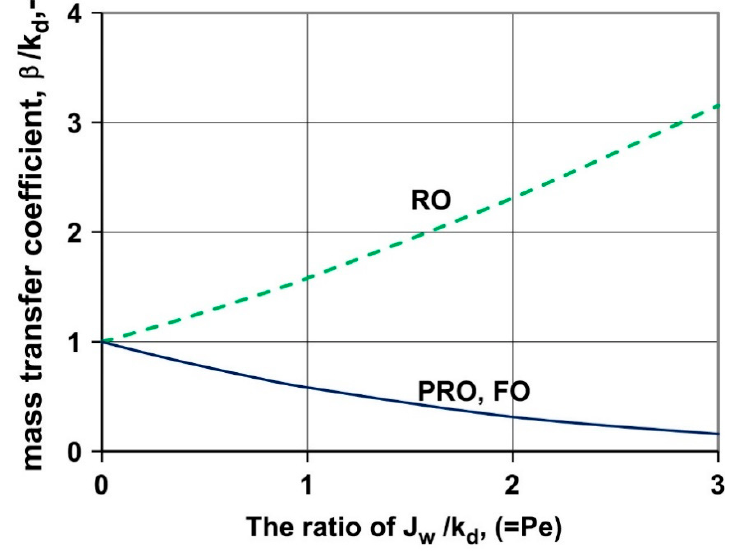
Figure 4. The variation of the dimensionless mass transfer coefficient ( β / k D ) according to the Pe number (i.e., J w / k D ). If the value of k is kept constant, the value of β / k D increases in the RO process as the Pe number increases. On the other hand, in the FO/PRO processes, the value of β / k D goes down while the Pe number increases. In this figure, A = 5 × 10 − 7 m/s/atm; B = 1.1 × 10 − 7 m/s; S = 7.2 × 10 − 4 m; k D = 5 × 10 − 5 m/s; C D , b = 58,500 ppm; C D , F = 2500 ppm; and ∆ P = 5 atm. [50] The figure is reproduced from Reference [50] with permission.